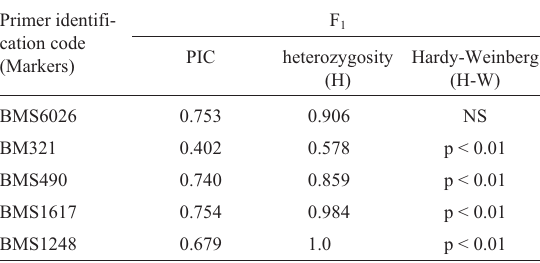
Table3 -Polymorphisminformationcontent(PIC)values,heterozygosity (H) and probability of Hardy-Weinberg equilibrium (H-W) for